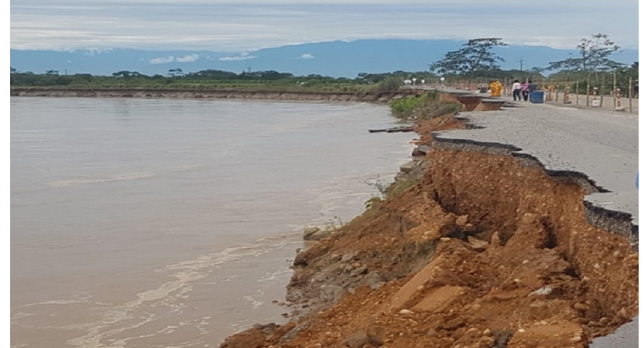
Figure 27. Ariari River, PR68: increased damage to the road embankment from intensive rains during